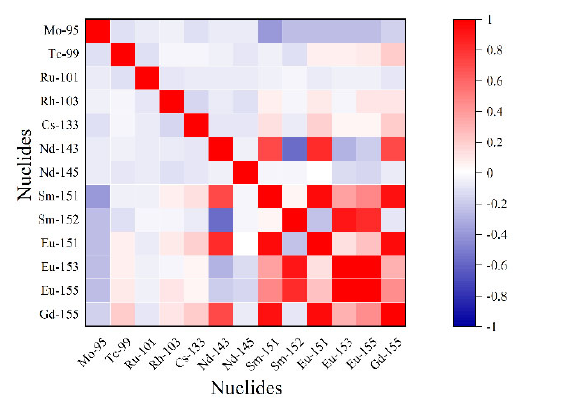
Fig.7. Correlation matrix of pseudo-experimental data.